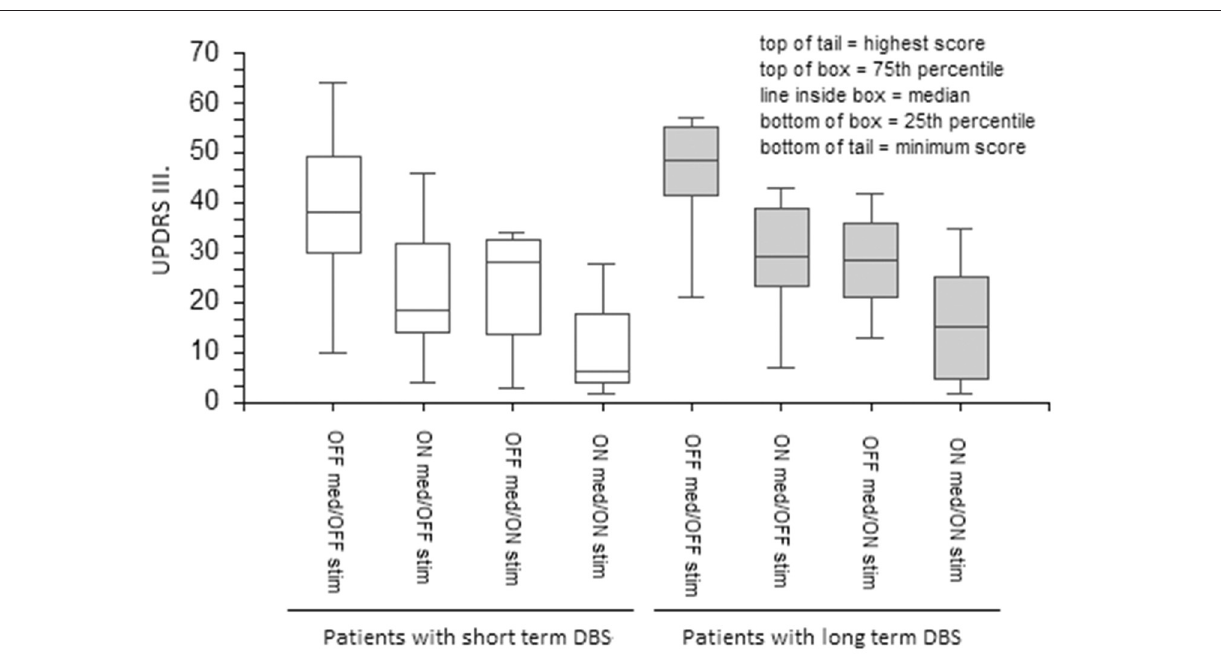
FIGURE 1 | The effect of medication and stimulation on UPDRS III in patients with short- and long-term DBS. UPDRS, The Unified Parkinson’s Disease Rating Scale; DBS, Deep Brain